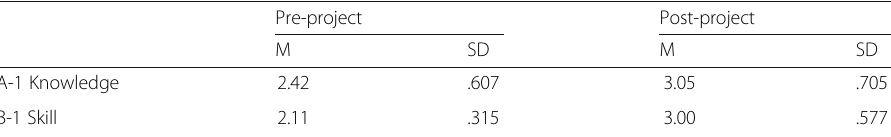
Table 1 Descriptive statistics of verbal communication knowledge and